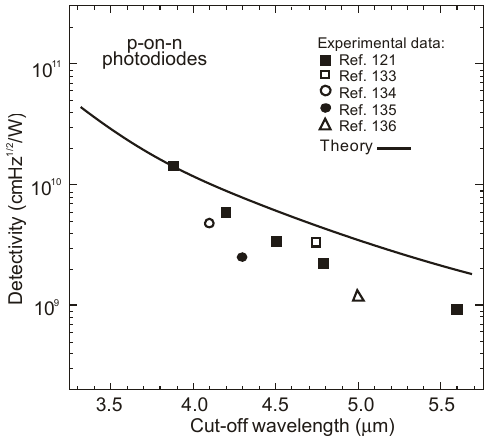
Figure 43. Normalized detectivity versus λ cut-off for InAs 1–x Sb x p-on-n and n-on-p photodiodes at room temperature. The theoretical line is calculated for 5- µ m thick active region with doping concentration of 10 16 cm − 3 . The gathered experimental data is taken from literature (after [91,121,133–136]).